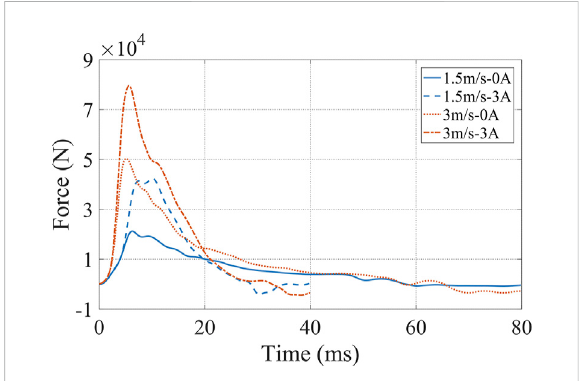
FIGURE 6 The experimental results for MREA at different impact speeds and